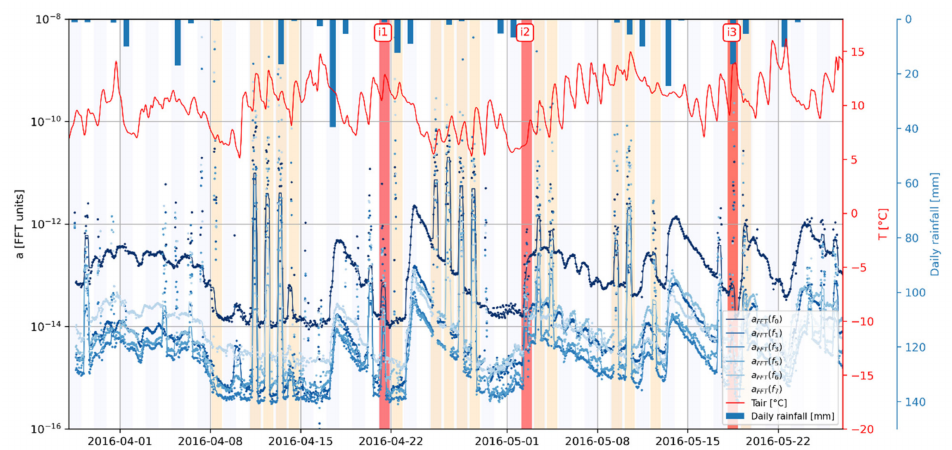
Figure A1. Spectral amplitude of peaks f 0 , f 1 , f 3 , f 5 , f 6 , and f 7 with time, labeled a FFT ( f n ) (logscale on Y-axis). Continuous lines show the rolling median computed on 12 h long windows. Air temperature on-site is shown as red curve, and daily rainfall is shown as blue bars (downward axis). Reinforcement work stages are shown in the background: drilling days (light orange) and grout injection (i 1 , i 2 , i 3 in